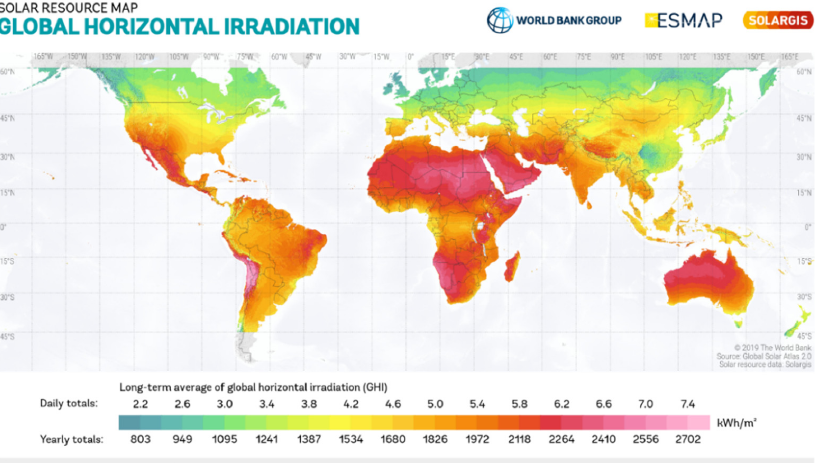
Figure 3. Global horizontal irradiation [18]. Note: Map obtained from the Global Solar Atlas 2.0, a free, web-based application is developed and operated by the company Solargis s.r.o. on behalf of the World Bank Group, utilizing Solargis data, with funding provided by the Energy Sector Management Assistance Program (ESMAP). For additional information: https://globalsolaratlas.info (accessed on 3 August 2022).